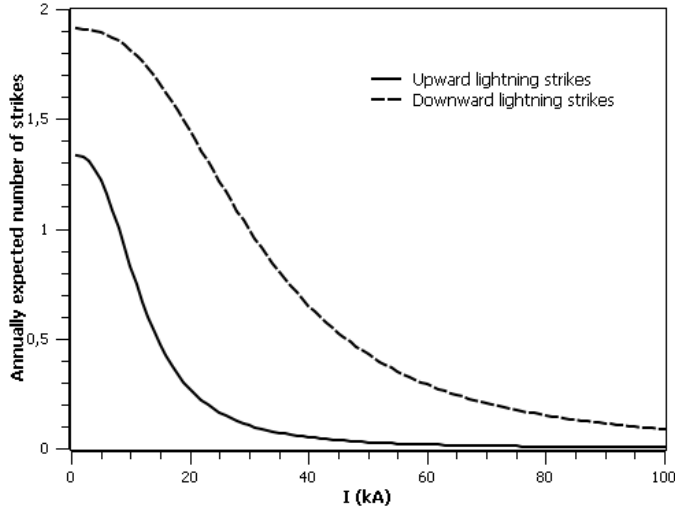
Figure 3. Lightning incidence of the wind turbine in respect to the upward- and downward-initiated lightning